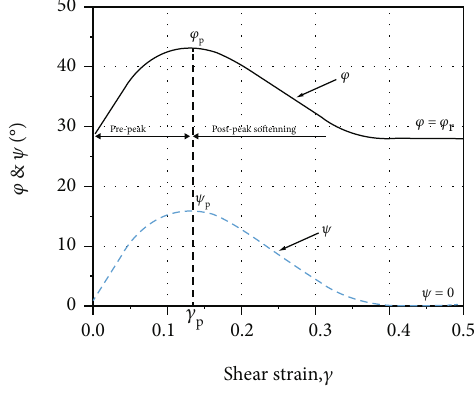
Figure 2: φ and ψ versus shear